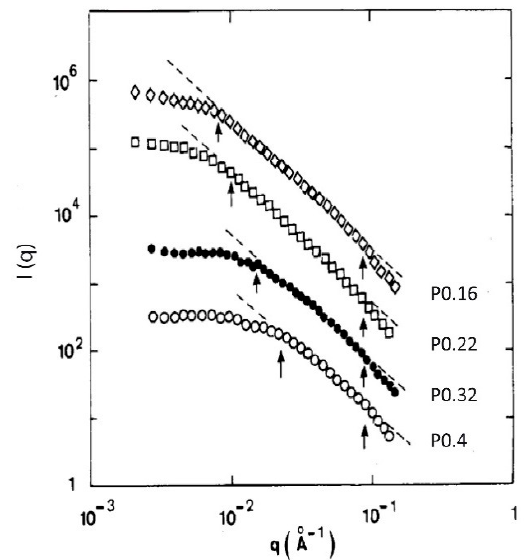
Figure 11. I(q) as measured by SAXS for the N18 compressed aerogels set (from [53]).